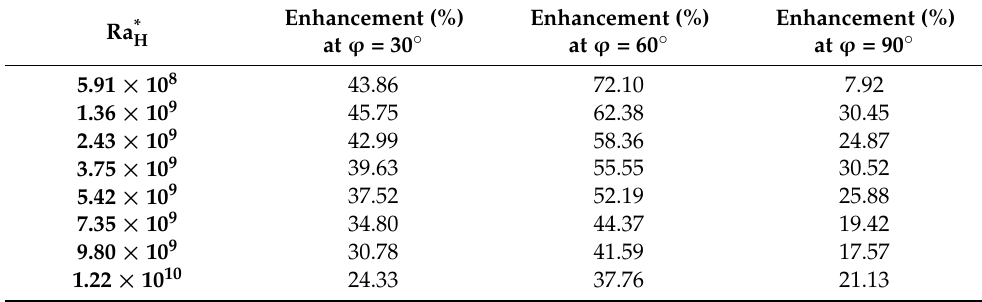
Figure 8. Nusselt numbers versus tilt angle for different 𝑅𝑎 H∗ . Table 3. The percentage of enhancement in the Nusselt numbers at different tilt angles compared to the horizontal enclosure according to Equation